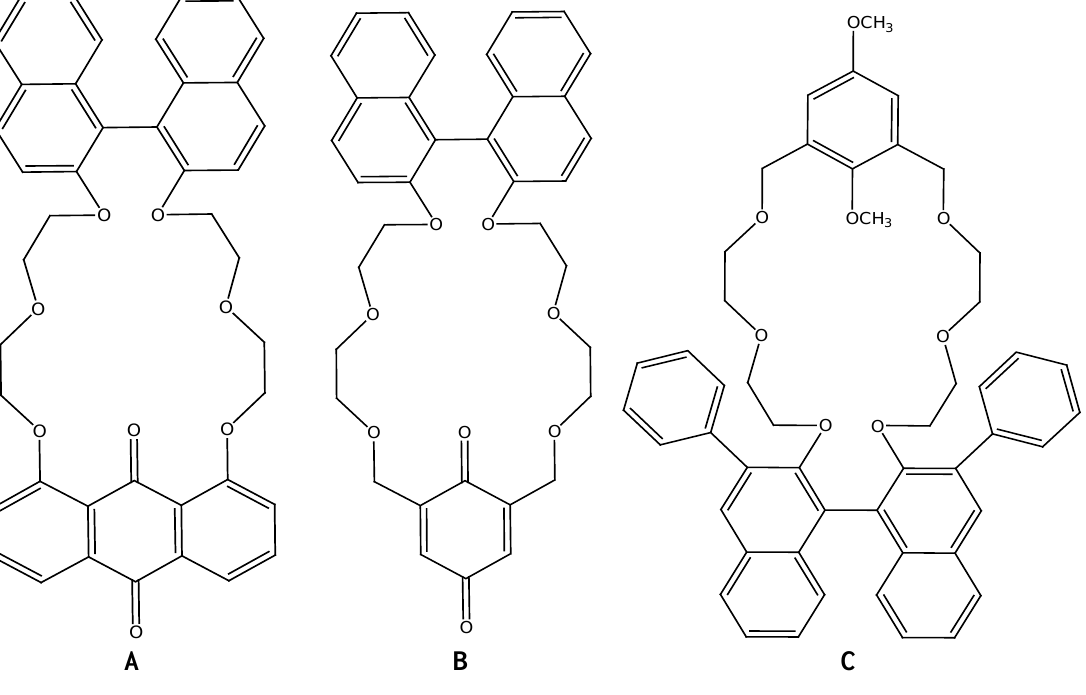
Figure 35. (1,1'-binaphtyl)-23-crown-6 incorporating 9,10-anthraquinon (A) , (1,1'-binaphtyl)-23- crown-6 incorporating 1,4-benzoquinon (B) , (3,3'-diphenyl-1,1'-binaphtyl)-23-crown-6 incorporating 1,4-dimethoxybenzen